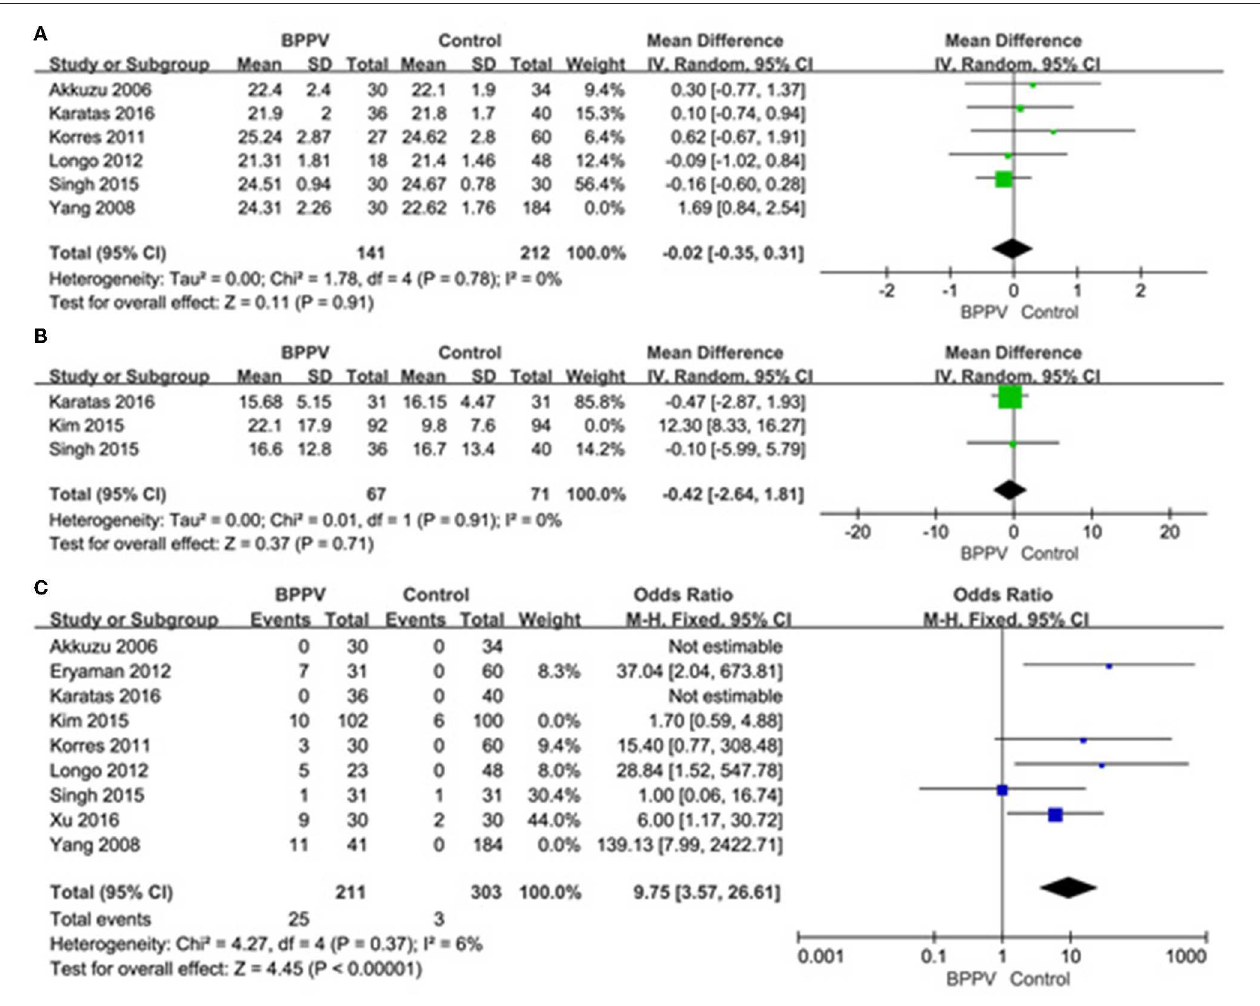
FIGURE 9 | (A) Sensitive analysis of n23 latency of cVEMP, indicating that the study of Yang et al. is the source of high heterogeneity. (B) Sensitive analysis of asymmetry ratio (AR) of cVEMP, indicating that the study of Kim et al. is the source of high heterogeneity. (C) Sensitive analysis of proportion of absent response of cVEMP, indicating that the studies of Yang et al. and Kim et al. are the source of high heterogeneity. BPPV, benign paroxysmal positional vertigo; cVEMP, cervical vestibular evoked myogenic